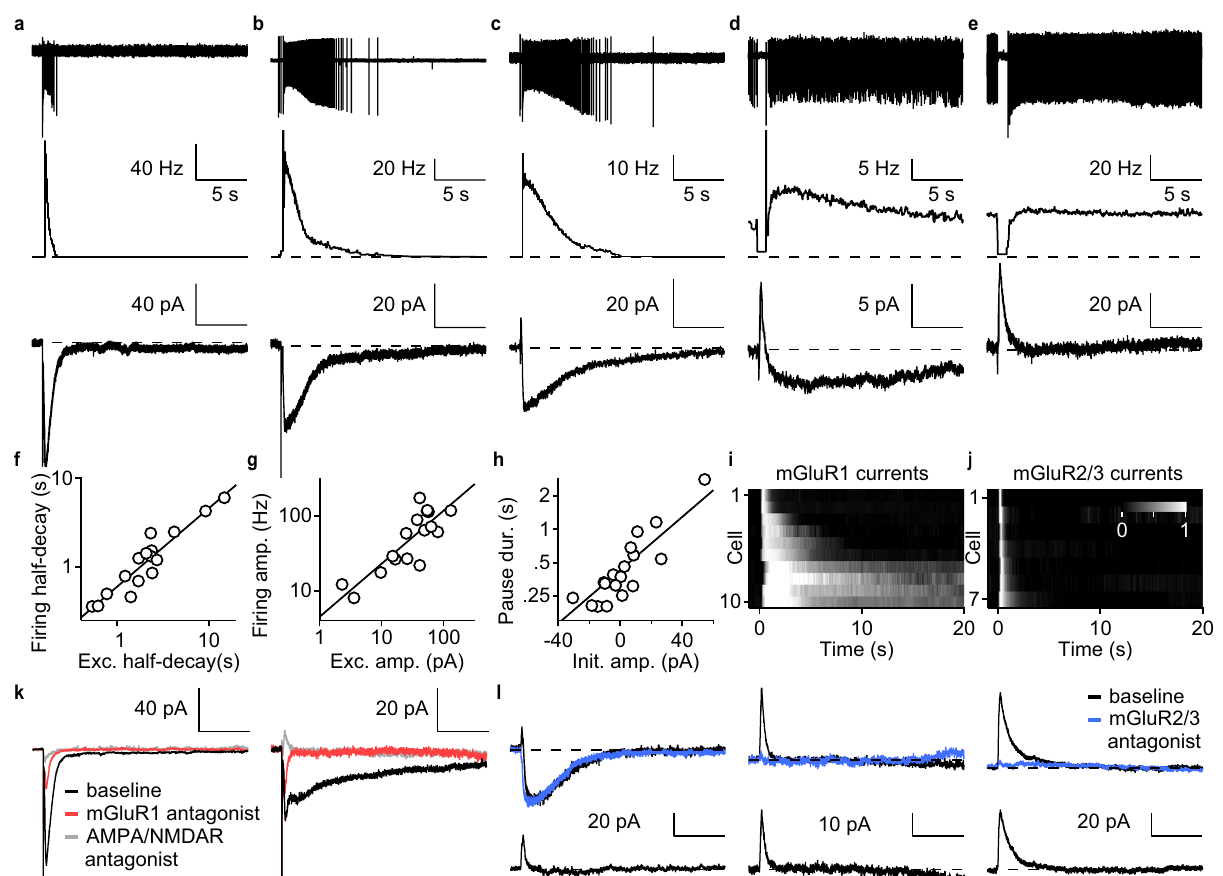
Fig. 5 mGluR1 and mGluR2/3-mediated synaptic currents determine the spiking kinetics. a Sample cell-attached recording (top) instantaneous fi ring rate (middle) and synaptic current measured with whole-cell voltage clamp (bottom) in a cell with fast response. b Same as in a but for a cell with intermediate speed response. c Same as in a but for a cell with clear biphasic synaptic current (bottom). d Same as in a but for a cell with slow biphasic response. e Same as in a but for a cell with only a pause in fi ring. f Half-decay times of fi ring rates vs. half-decay times of currents and linear fi t on a log-log plot ( R adj 2 = 0.91, slope = 0.88, intercept = − 0.22, n = 17). g Peak fi ring rate vs. peak current amplitude and linear fi t on a log-log plot ( R adj 2 = 0.69, slope = 0.71, intercept = − 0.65, n = 17). h Pause duration vs. amplitude of the current at stimulation offset, and linear fi t with log 10 response variable (black, R adj 2 = 0.44, slope = 0.01, intercept = − 0.42, n = 20). i Heatmap of peak normalized mGluR1-mediated current ( n = 10). j Heatmap of peak normalized mGluR2/3-mediated current ( n = 7). k Average synaptic response before (black), after (red) mGluR1 antagonist, and after AMPA/NMDA receptor antagonist wash-ins (gray). Each trace is an average of 8 trials. l Average synaptic response before (top, black) and after (top, blue) mGluR2/3 antagonist wash-in, and their difference (bottom, black). Each trace is an average of 8